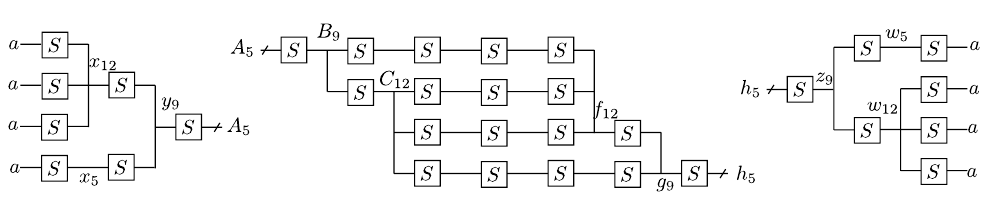
Figure 11: The difference propagation of E 0 (left), the difference propagation of E m (middle) and the difference propagation of E 1 (right)